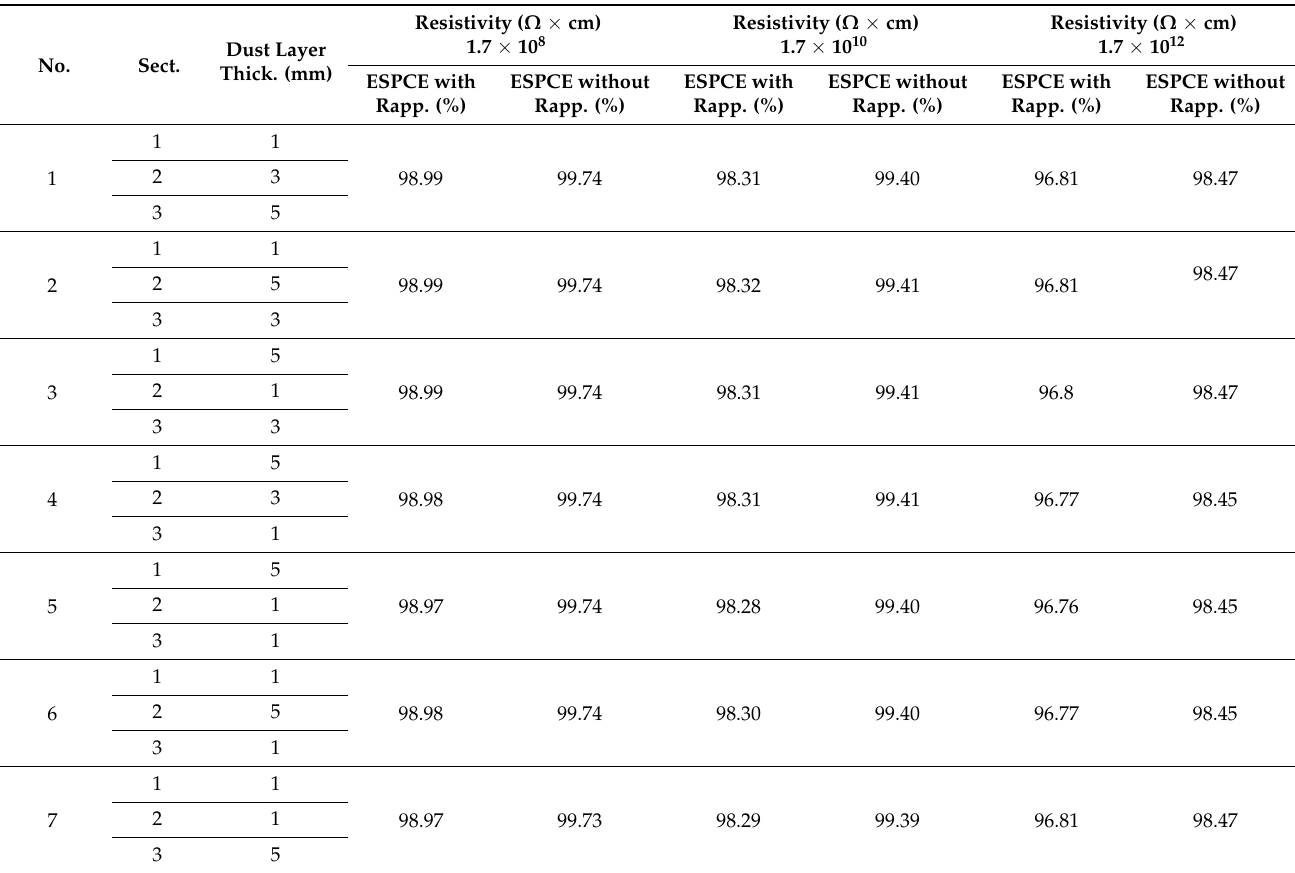
Table 12. Simulations of ESP performance when the thickness of the dust layers varies in the sections and the average diameter of the dust particles is 16 µ